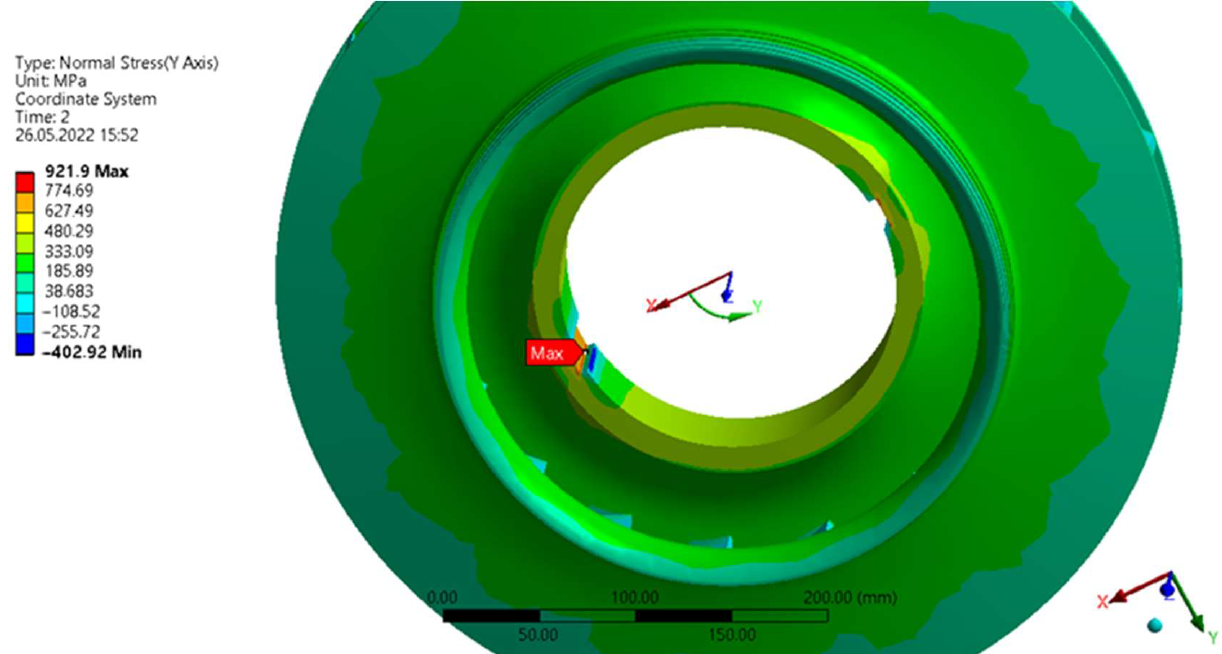
Figure 9. Hoop stress distribution caused by the centrifugal force, the shrink fit and the presence of the keyways.